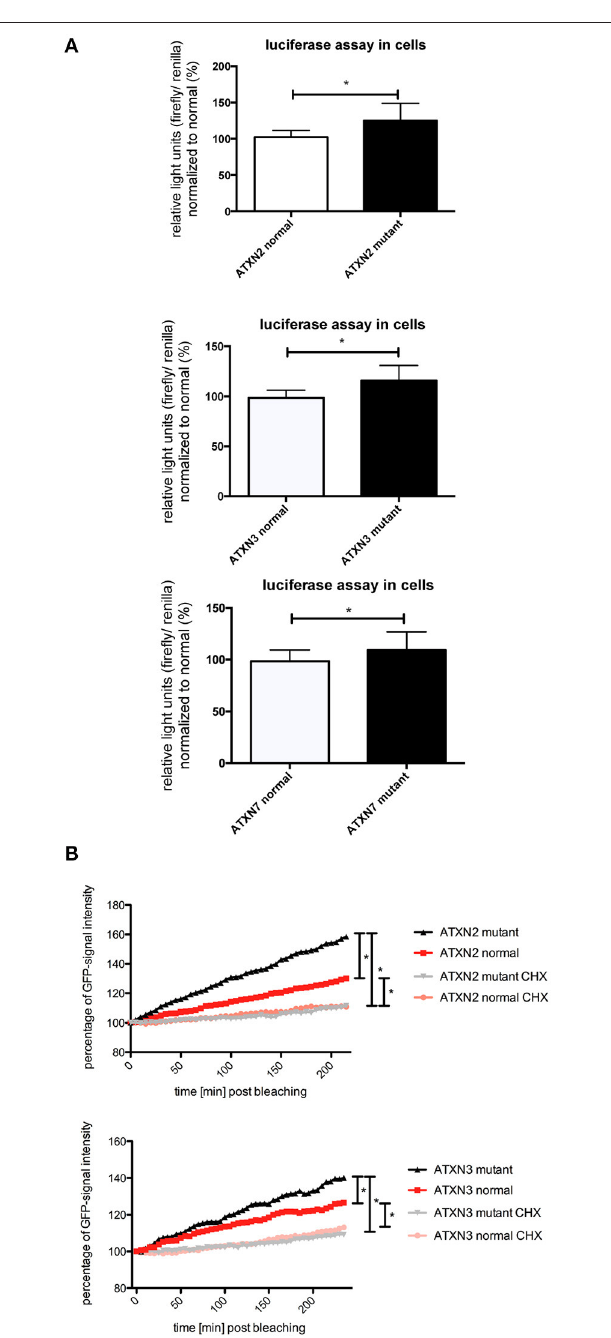
FIGURE 3 | Enhanced translation of ATXN2 , ATXN3 , and ATXN7 constructs with expanded CAG repeats in cell lines. (A) Dual luciferase reporter assay in HEK293T cells transfected with constructs containing a firefly luciferase reporter with the CAG repeat region of ATXN2 , ATXN3 , and ATXN7 in the 3 ′ UTR and renilla luciferase as an internal transfection control. Data shown represent relative light units of the ATXN2 , ATXN3 , and ATXN7 firefly luciferase construct normalized to renilla luciferase. The mean of the constructs with normal CAG repeat length was set to 100%. Columns represent mean values ± SEM. n = 6, p < 0.05 (B) Fluorescence recovery after photobleaching assays to monitor translation were performed